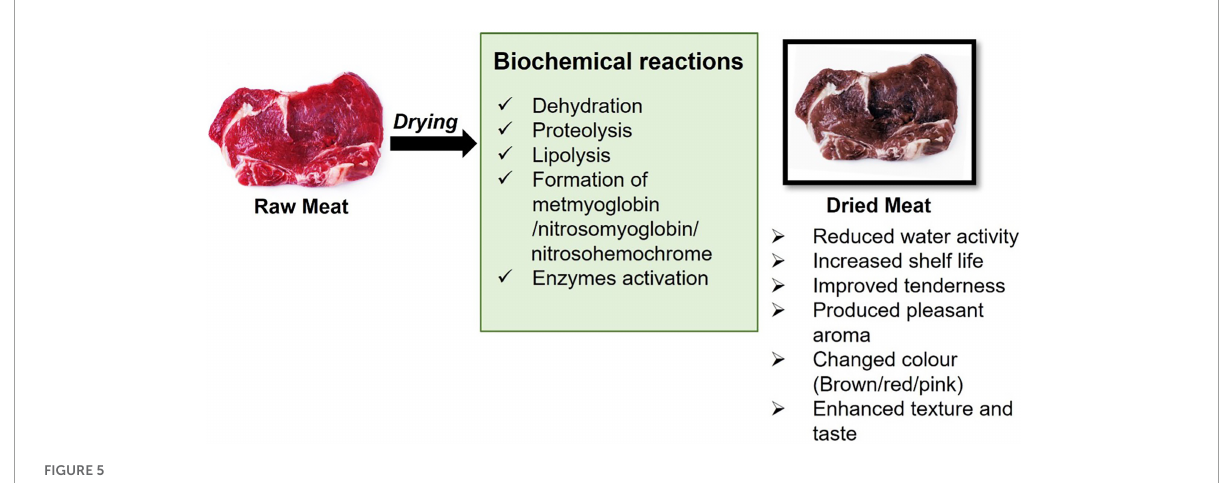
FIGURE5 Biochemical reactions and changes occur during meat